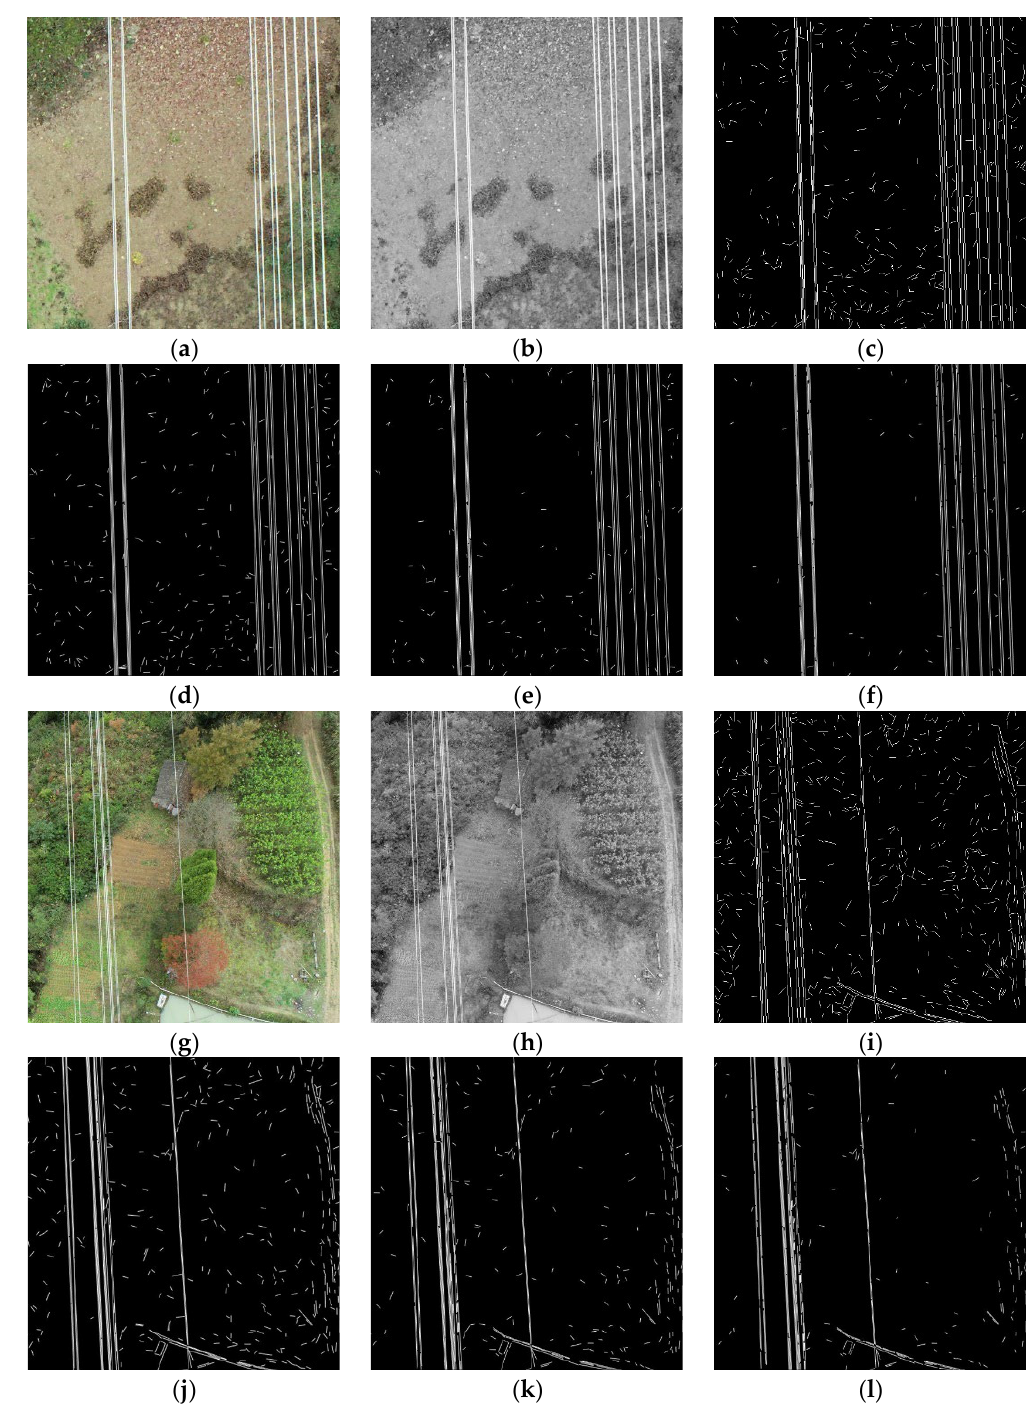
Figure 11. Detection results with different thresholds in the multi-scale LSD. ( a ) Low IC image; ( b ) Gray image of ( a ); ( c ) LSD result of ( a ); ( d ) x = 0.4; ( e ) x = 0.6; ( f ) x = 0.8; ( g ) High IC image; ( h ) Gray image of ( g ); ( i ) LSD result of ( g ); ( j ) y = 0.5; ( k ) y = 0.7; ( l ) y = 0.9.